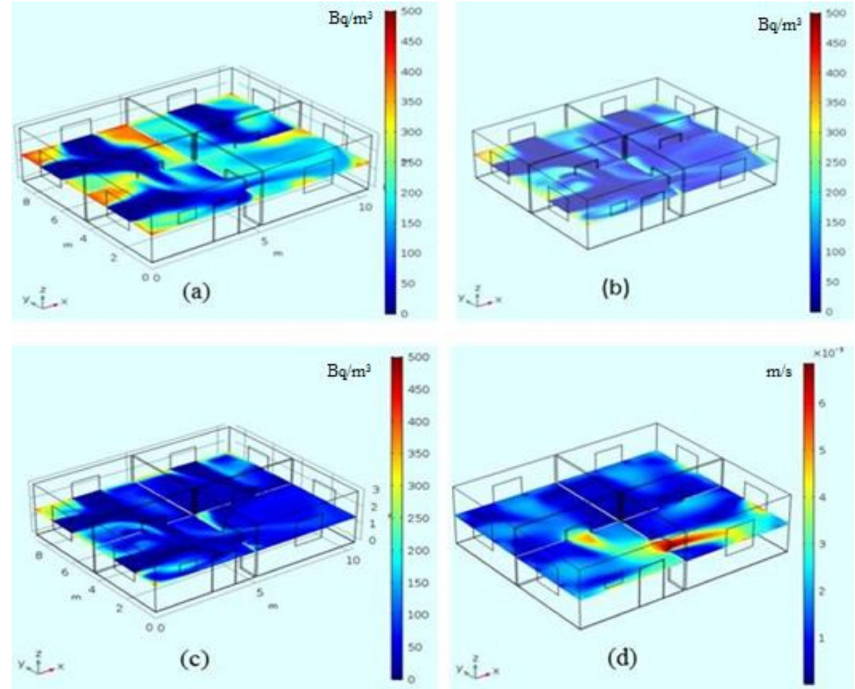
Figure 3. Radon concentration changes vs. air exchange rate, ( a ) λ = 0.17 h − 1 ; ( b ) λ = 0.34 h − 1 ; ( c ) λ = 0.51 h − 1 ; and ( d ) velocity magnitude distribution for λ = 0.17 h − 1 , z = 1.5